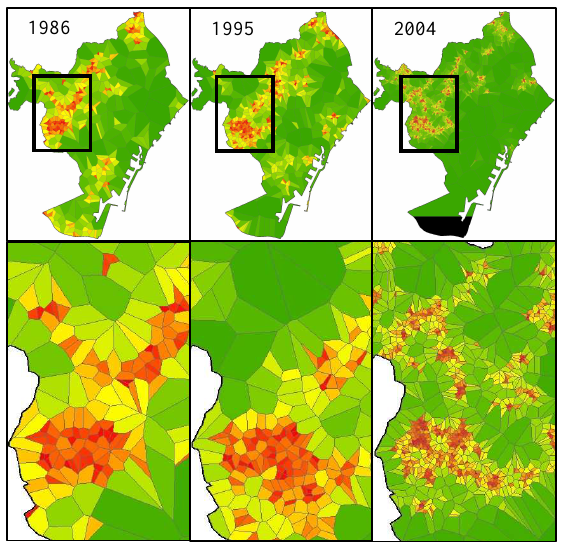
Figure 12: Dynamic Voronoi for multi-temporal map illustrates change detection presented by moving cluster centroid from Voronoi cells.